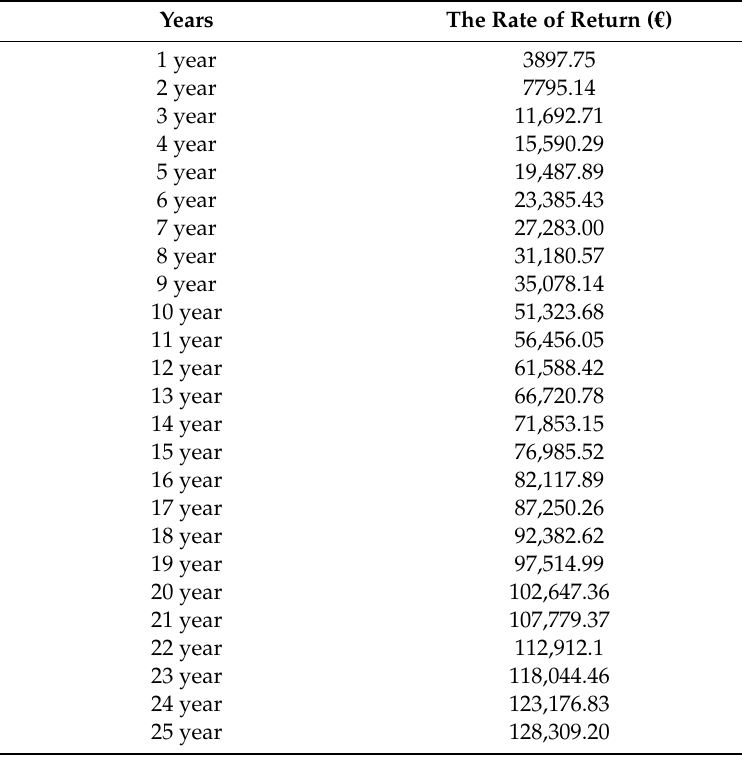
Table 4. The rate of return on investment due to energy generation throughout the 25-year